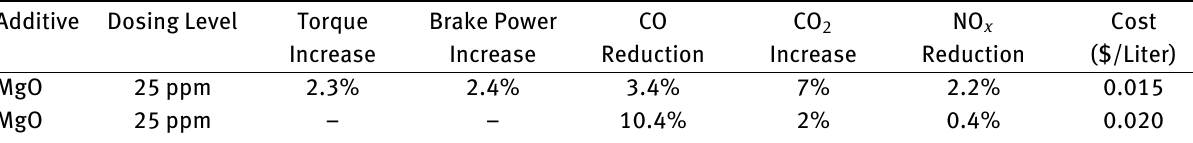
Table 2: Changes in the Engine Performance and Emissions of Biodiesel Fuel [37]. Additive